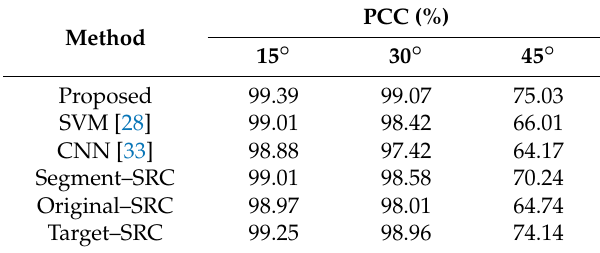
Table 9. Comparison with reference methods for different depression